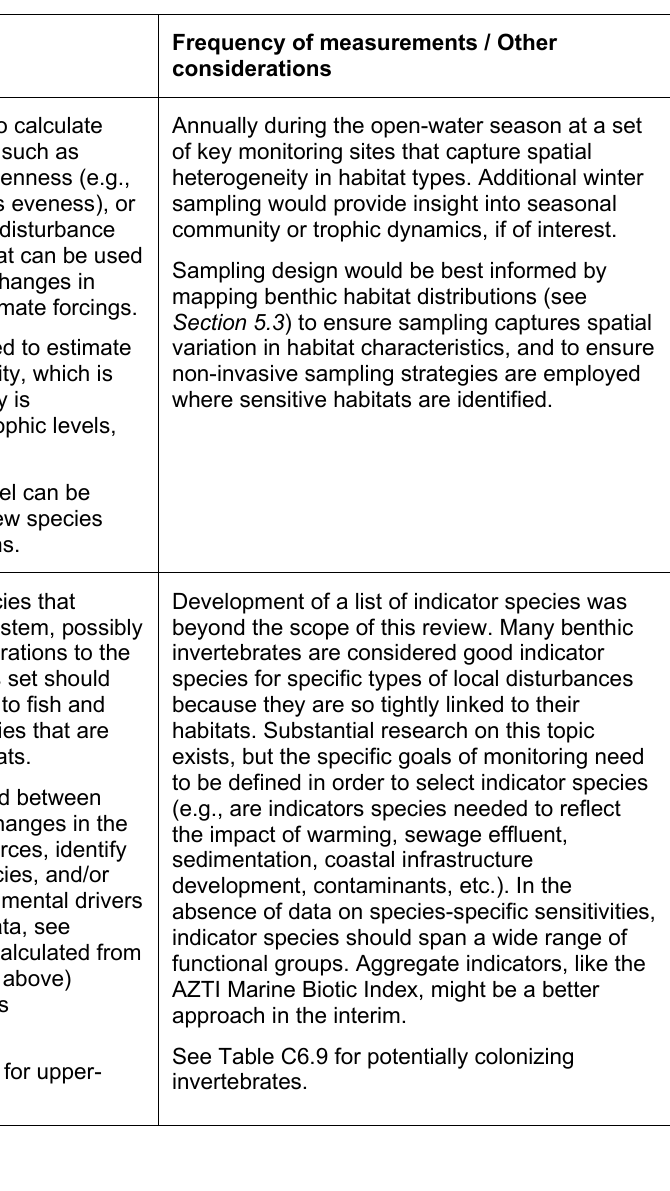
Table C6.4. Key measurement parameters for monitoring benthic invertebrate community composition, structure, and function (Section